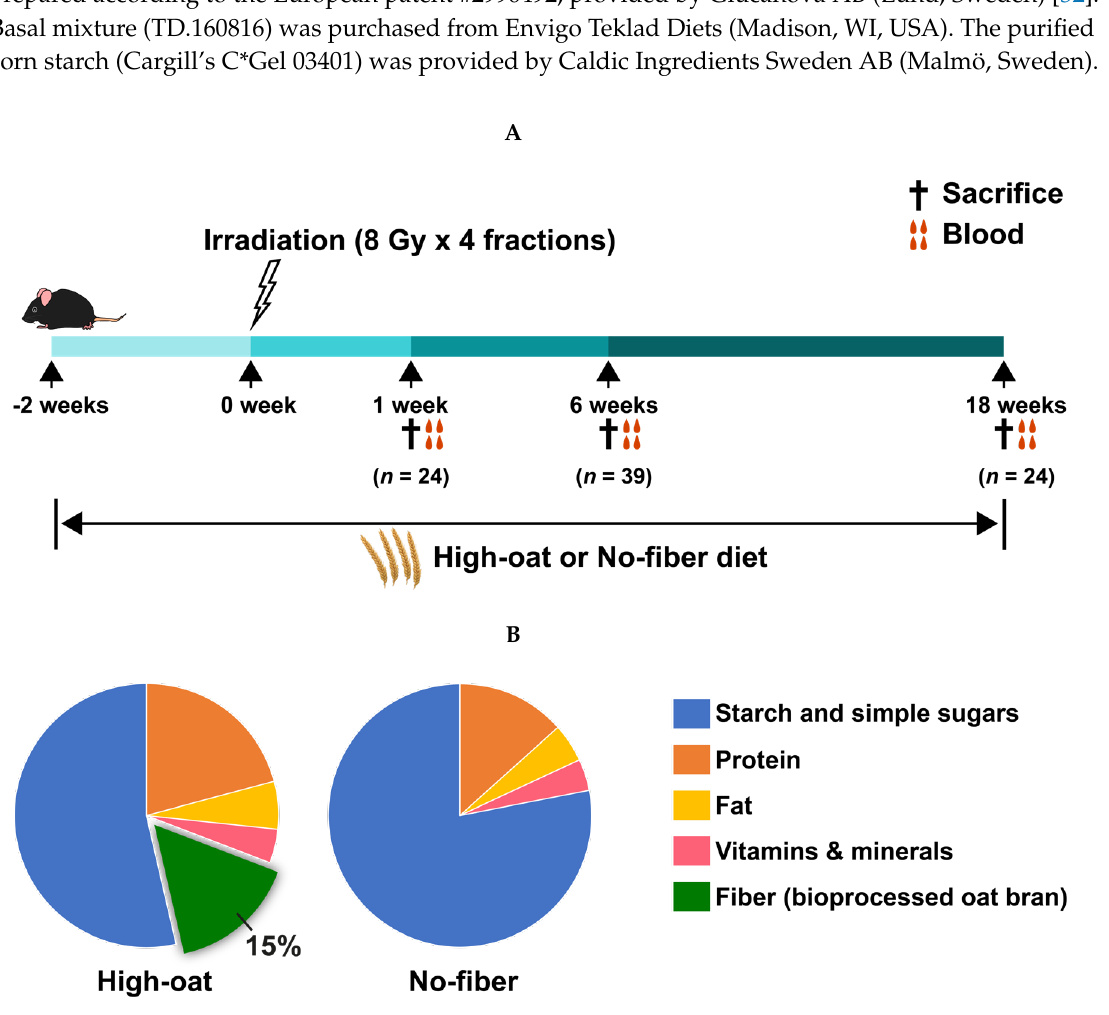
Figure 1. Experimental design. ( A ) Mice were fed the High-oat or No-fiber diet starting at 2 weeks before irradiation until 1, 6, and 18, weeks post-irradiation. Mice were sacrificed at 1, 6, and 18 weeks post-irradiation followed by blood sample collection. ( B ) Compositions of the High-oat and the No-fiber diets.